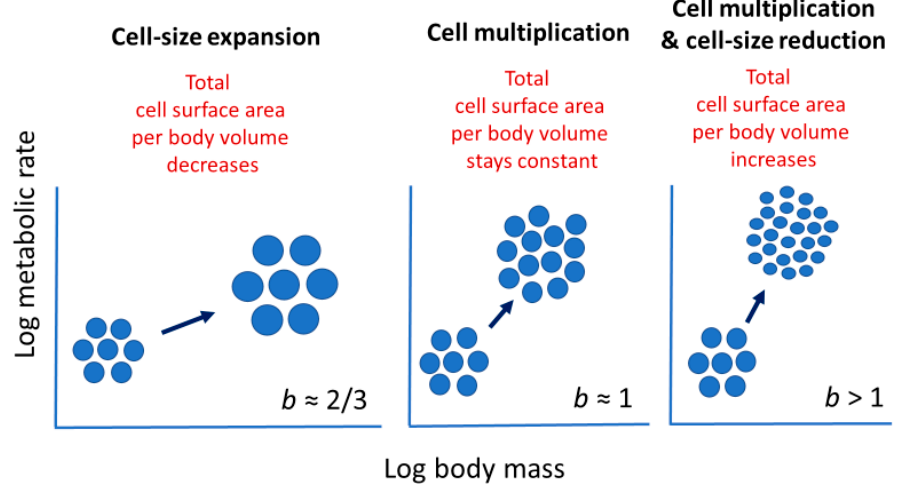
Figure 2. Schematic representation of how various cellular modes of body growth (cell-size expansion, cell multiplication, and cell multiplication with cell-size reduction) should affect the ontogenetic scaling of metabolic rate with body volume or mass (scaling exponent b = loglinear slope), according to cell-size metabolic scaling theory (see text and [23,24,27]). If both cell expansion and multiplication occur during growth, b should be between 2/3 and 1.